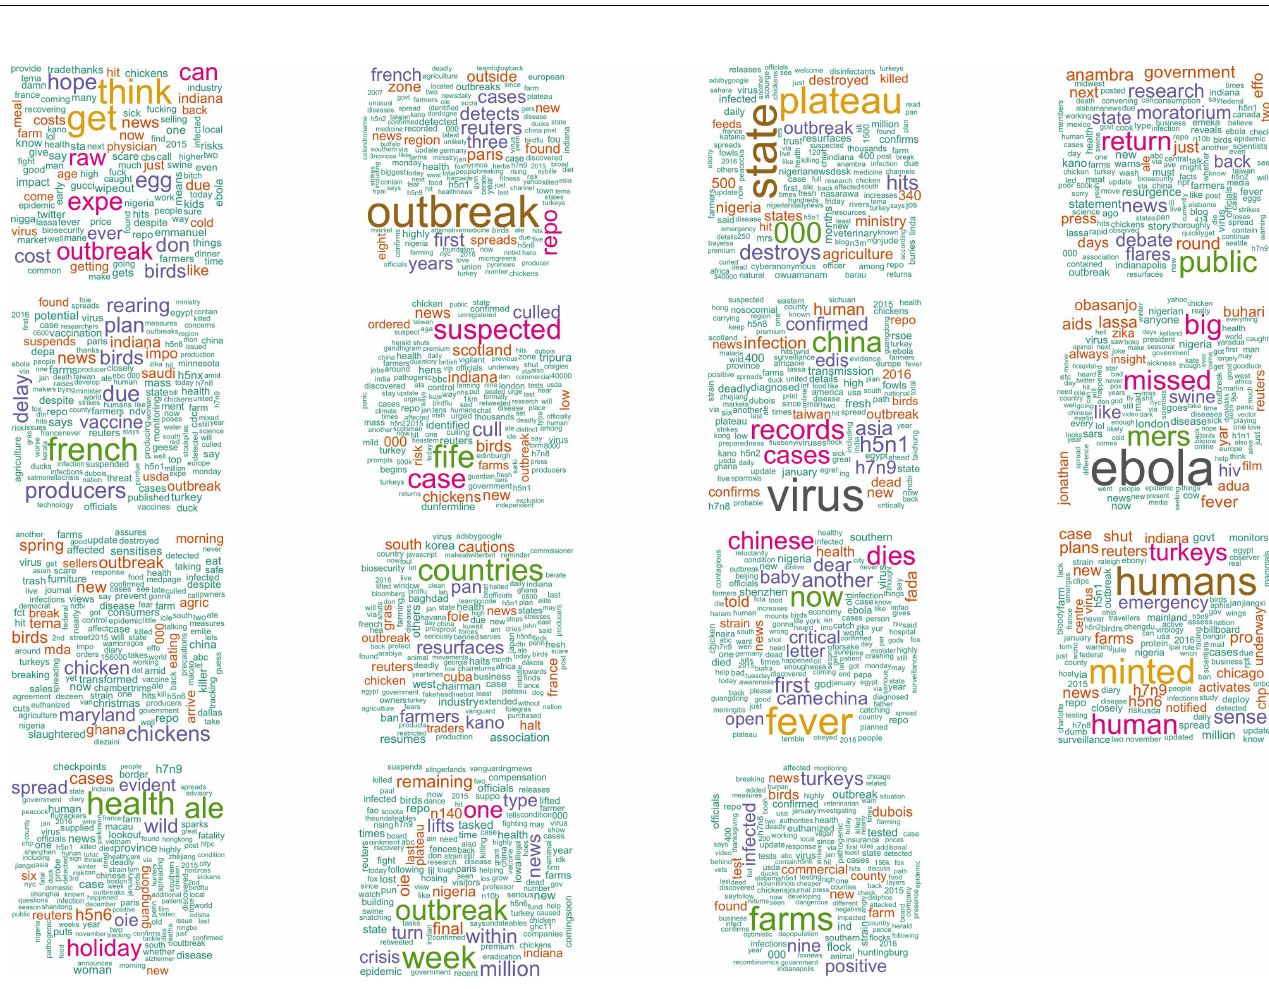
Fig 8. Wordclouds generated from original Tweets associatedwith topic models discovered from outbreaks based on the dynamic threshold method.